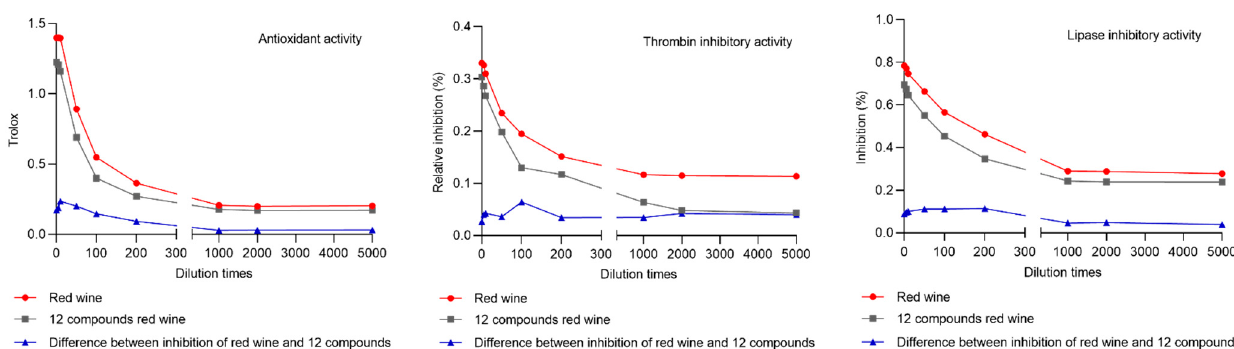
Figure 6. The inhibition ratios of red wine and 12 active compounds mixture with different dilution times and the difference between inhibition of red wine and 12 compounds mixture.